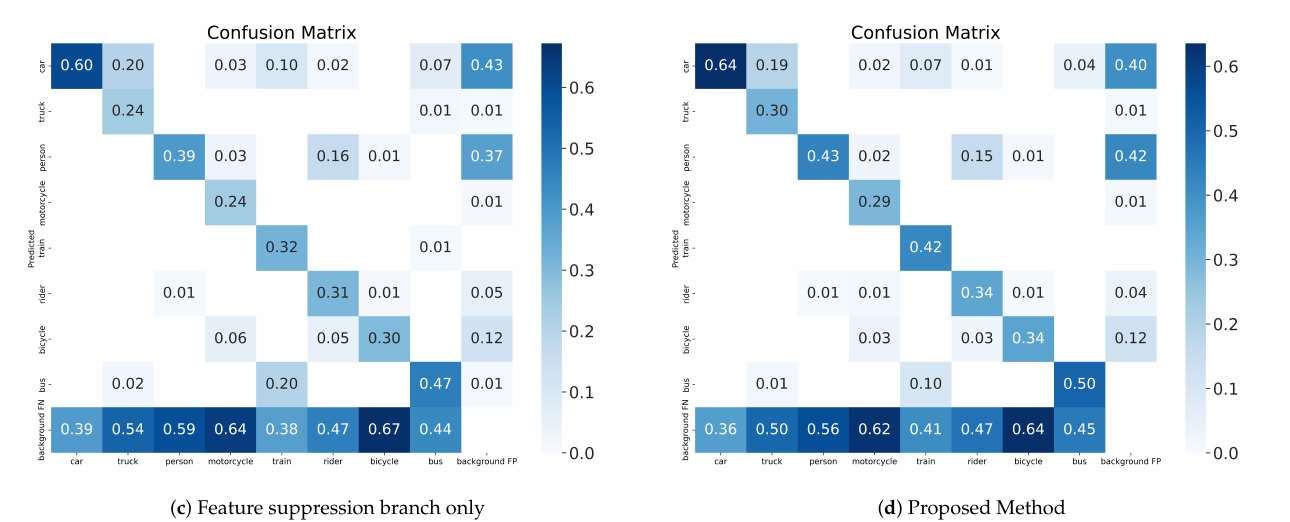
Figure 8. Confusion Matrix on Cityscapes → Foggy Cityscapes transfer.